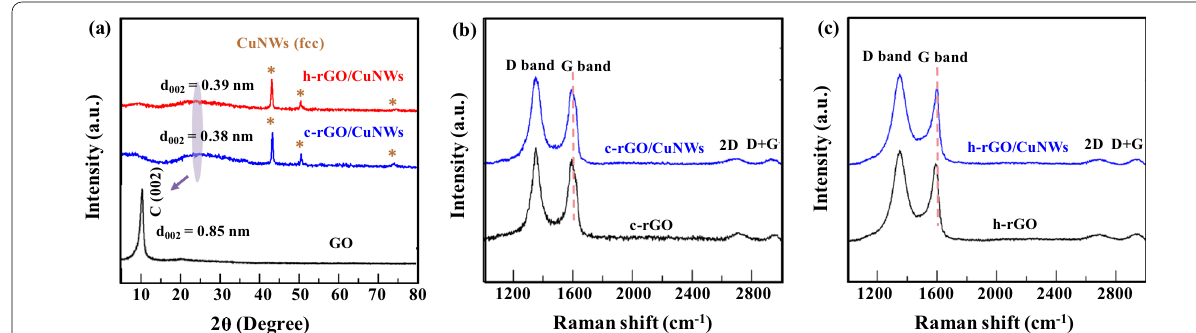
Fig. 3 a XRD patterns of GO, c‑rGO/CuNWs, and h‑rGO/CuNWs films. The graphitic peak (002) shifts to higher angles after chemical reduction and hydrogen‑annealing reduction, indicating the restacking of rGO sheets. The copper crystal planes show the rGO‑coated CuNWs films. b Raman spectra of c‑rGO and c‑rGO/CuNWs films. c Raman spectra of h‑rGO and h‑rGO/CuNWs